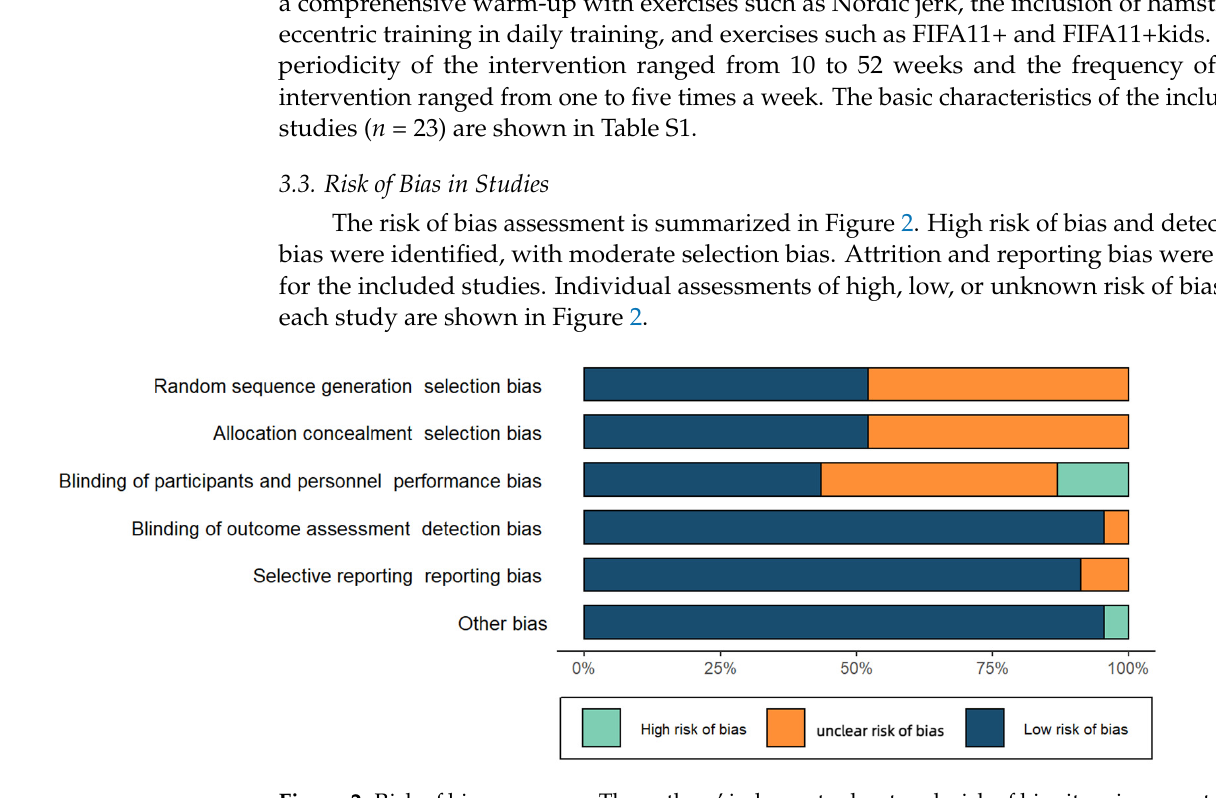
Figure 2. Risk of bias summary. The authors’ judgments about each risk of bias item is presented as percentages across all included studies.